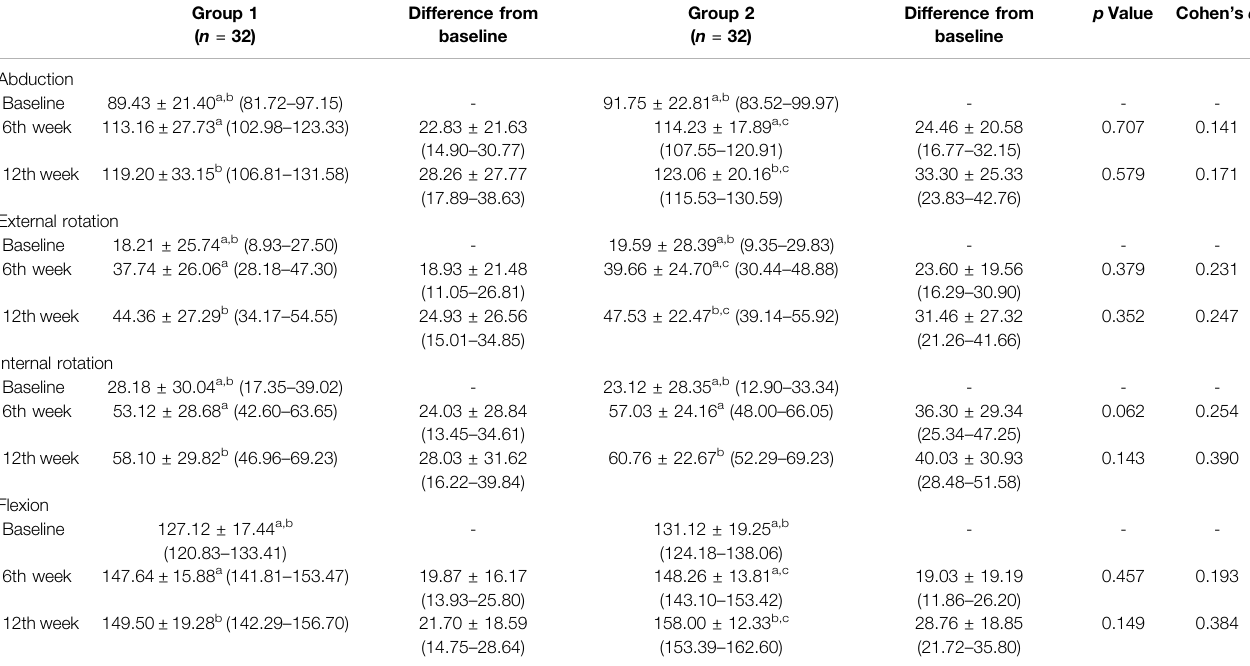
Thevaluesaregivenasmean ± standarddeviation(95%con fi denceintervalofmean). p valuespertaintobetween-groupcomparisonsfordifferencesfrombaseline.*indicates p < 0.05. Group 1 indicates hydrodilatation though the posterior glenohumeral recess, whereas Group 2 indicates hydrodilatation through the rotator cuff interval. a signi fi cant difference between baseline and the 6 weeks in the same group. b signi fi cant difference between baseline and the 12 weeks in the same group. c signi fi cant difference between the 6 and 12 weeks in the same